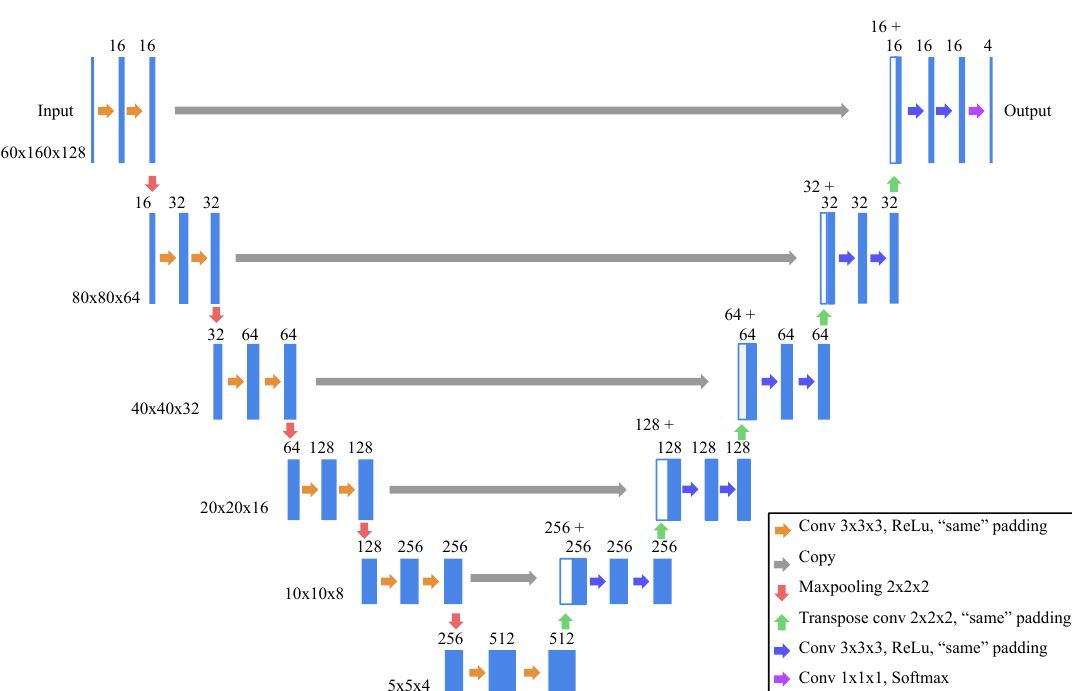
Figure 3. 3D U-net model architecture. Each blue rectangle represents the feature maps resulting from a convolution operation, while white rectangles represent copied feature maps. For the convolutions, zero padding was chosen such that the volume size was preserved (“same” padding). The output size was 4: one per segmentation (bladder, rectum, and prostate) and one for the